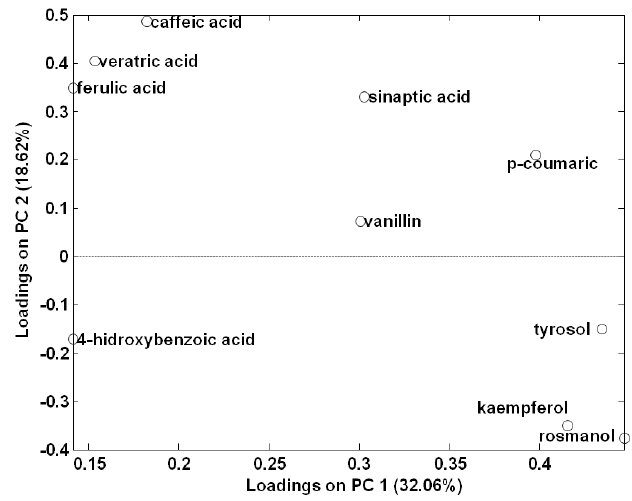
Figure 5. PCA results (score and loading plots of PC1 vs. PC2) using as analytical data the normalized peak areas of the fourteen targeted polyphenols and phenolic acids found in the analysed olive oils.